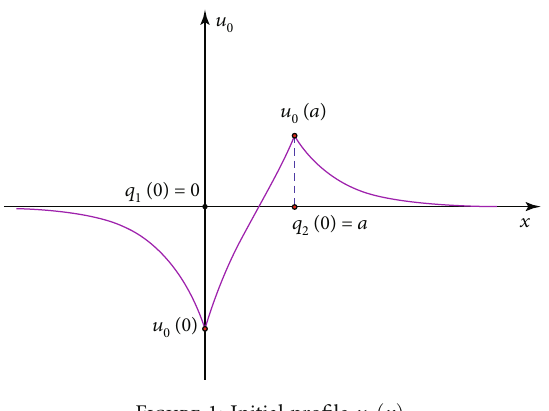
Figure 1: Initial pro fi le u